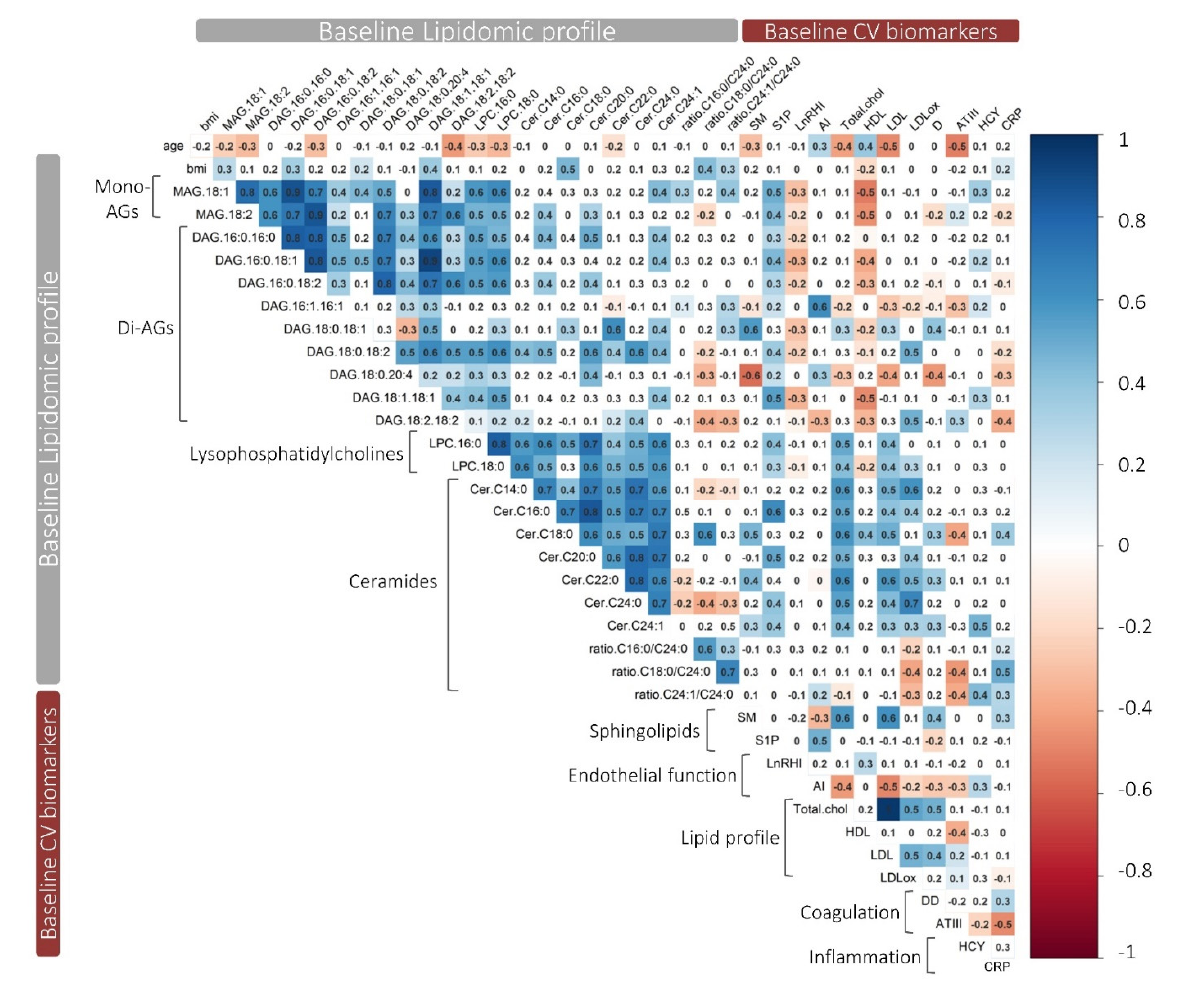
Figure 2. Correlation matrix of the lipidomic profile with CV biomarkers at the baseline of the study. Pearson’s correlation matrix of the lipidomics with CV biomarkers ( n = 33) at baseline. Blank squares represent correlations with a p -value > 0.05. Positive correlations are shown in blue and negative correlations are shown in red. Abbreviations: AGs, acylglycerols; CV, cardiovascular; SM, sphingomyelin; S1P, sphingosine 1 phosphate; LnRHI, logarithm of reactive hyperemia index; AI, augmentation index; Total chol, total cholesterol; DD, D-dimer; HCY, homocysteine; CRP, C-reactive protein.